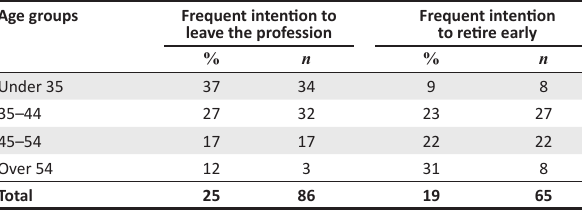
TABLE 2: Age groups and frequent intentions for job